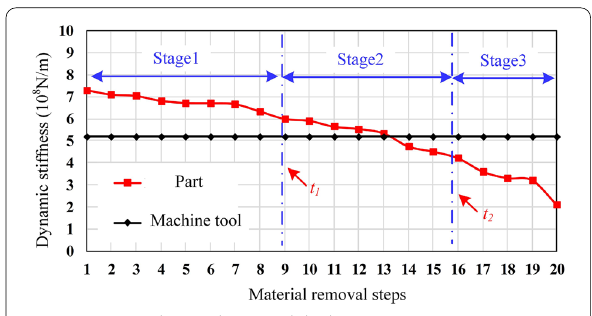
Figure 3 Stage division by critical